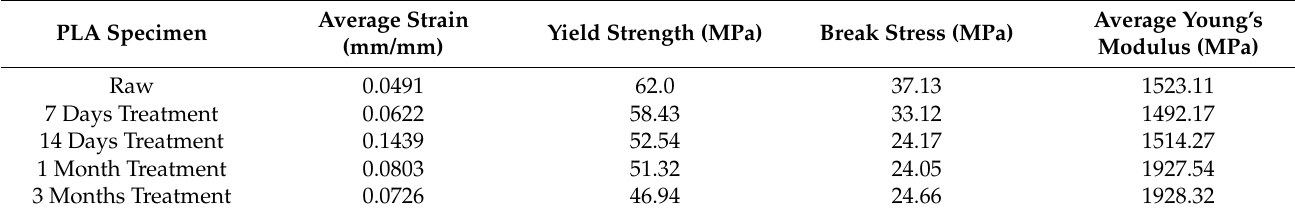
Figure 8. Stress and strain curves of PLA dog-bone specimens in tension test: ( a ) Raw PLA and aged PLA after alkaline treatment for 7 and 14 days, ( b ) aged PLA after alkaline treatment for 1 and 3 months. Table 3. Summary of tensile test on dogbone PLA specimens.